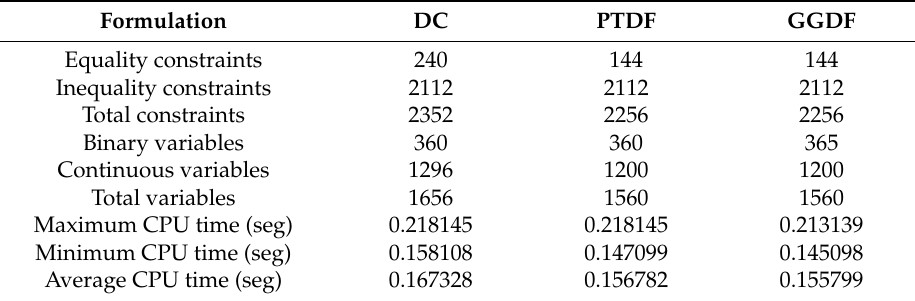
Table 2. Computational aspects of the PJM 5-bus system.